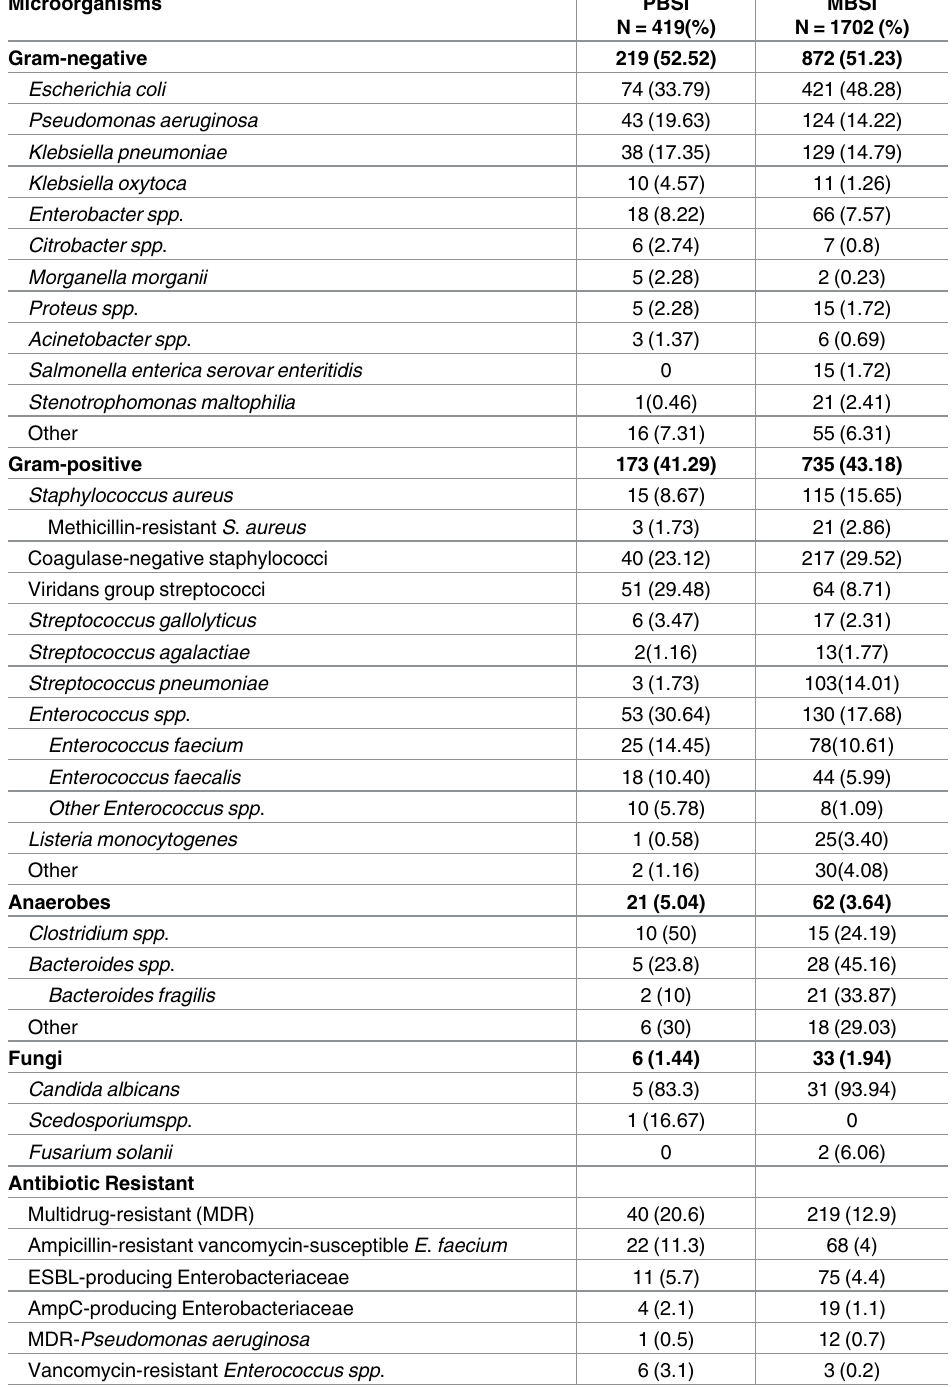
Table 3. Aetiology of all episodes of bloodstream infection compared by